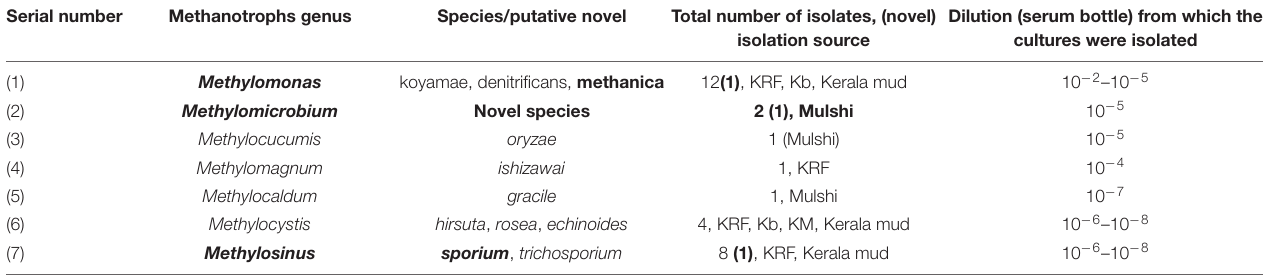
TABLE 1 | Cultivated methanotroph strains from various